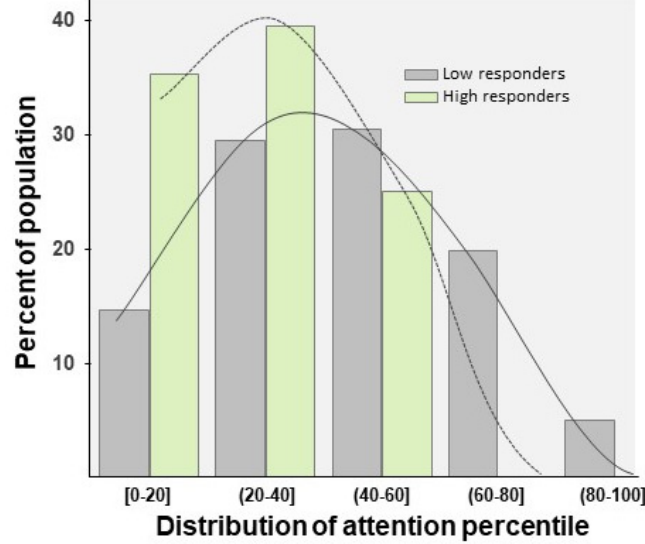
Figure 6. The graph shows the distribution of the LR and HR population according to the percentile of attention. Dotted line: HR scores; solid line: LR scores.